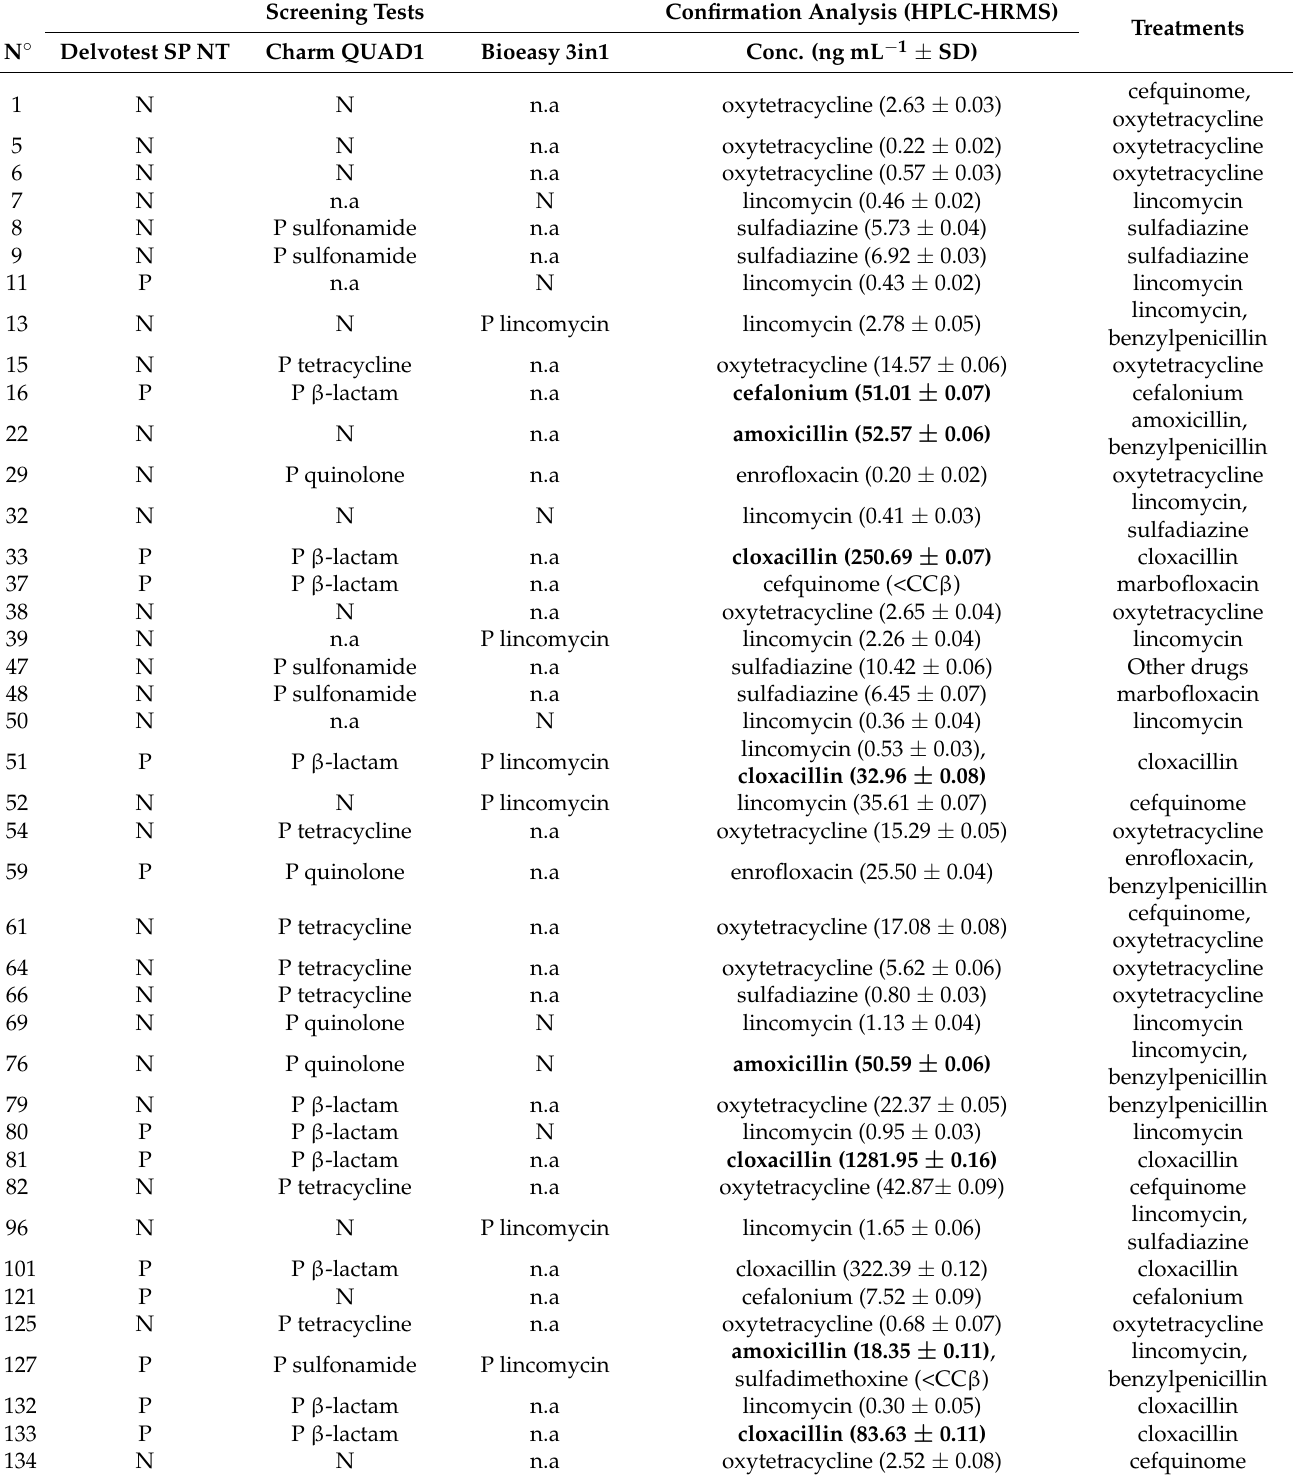
Table 3. Confirmed samples with antibiotic presence, relative screening test results and information about